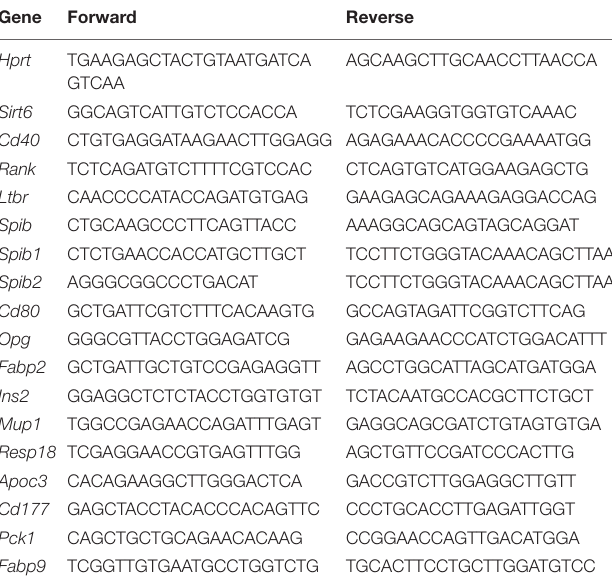
TABLE 1 | The list of primers used in qPCR